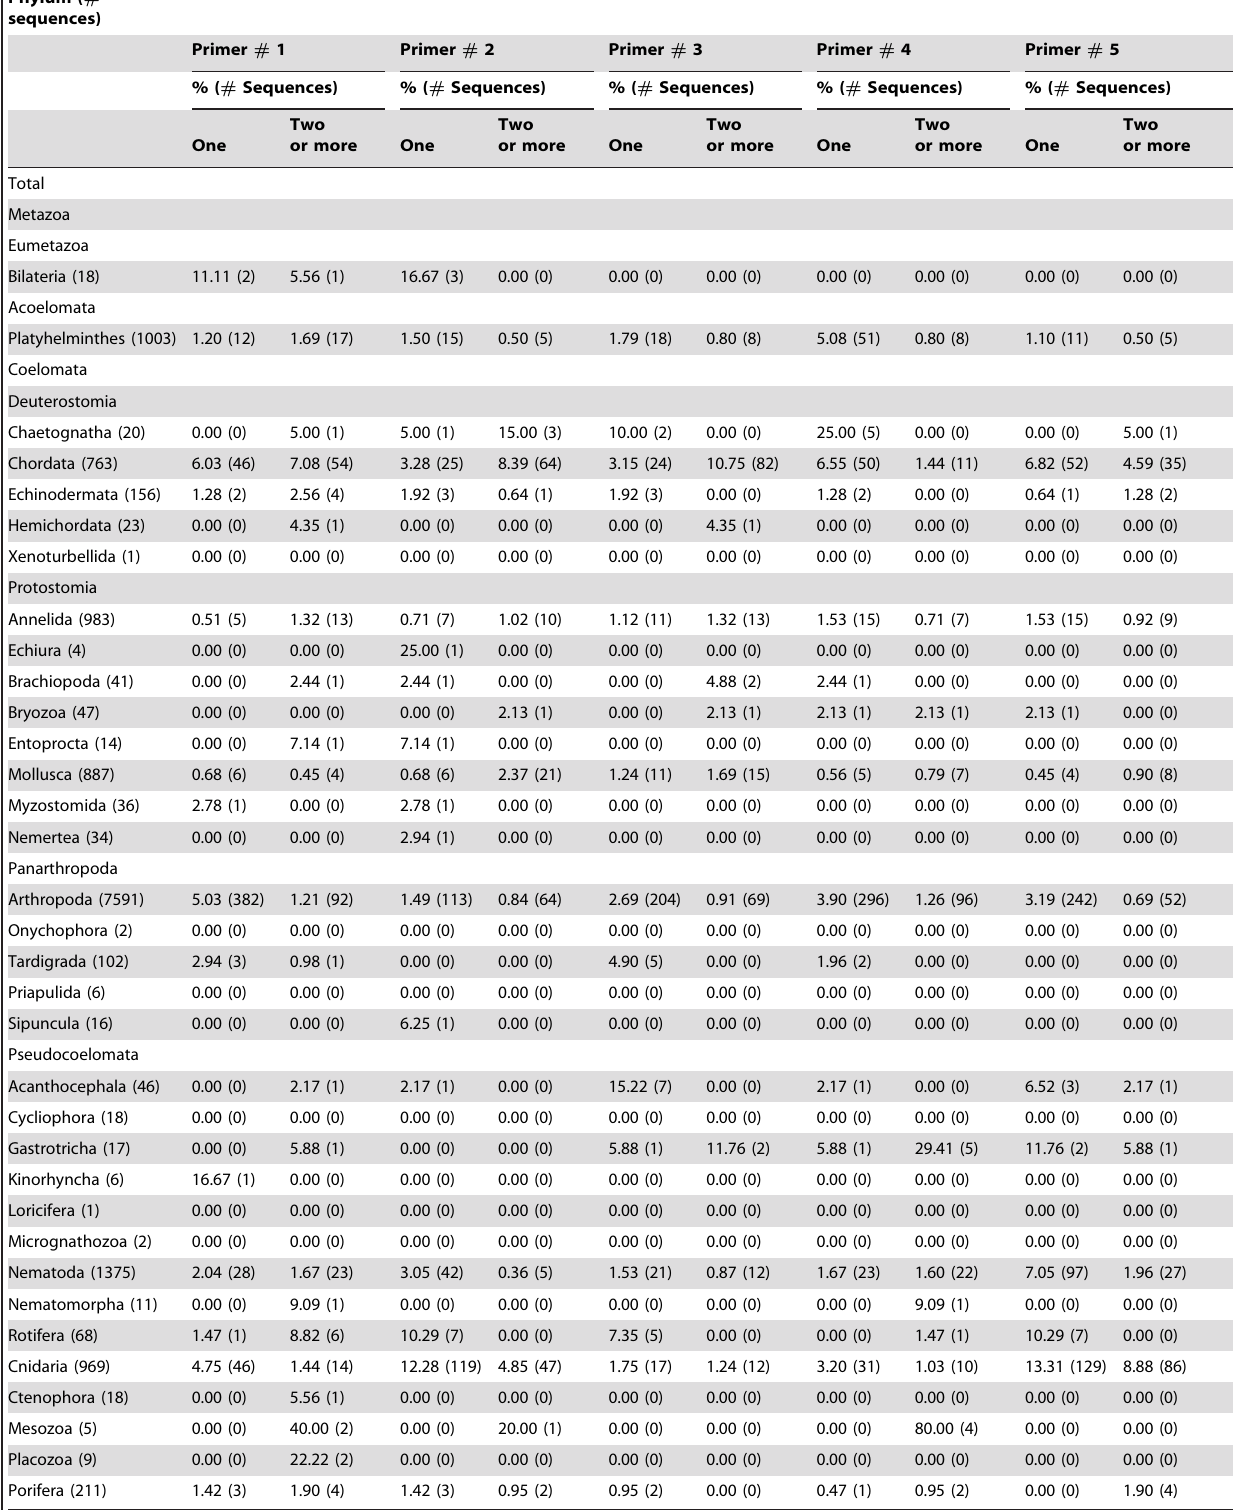
Table 2. Percentages of sequences, which showed mismatches between the primer and target regions of the nuclear 18S ribosomal DNA sequences downloaded from the SILVA